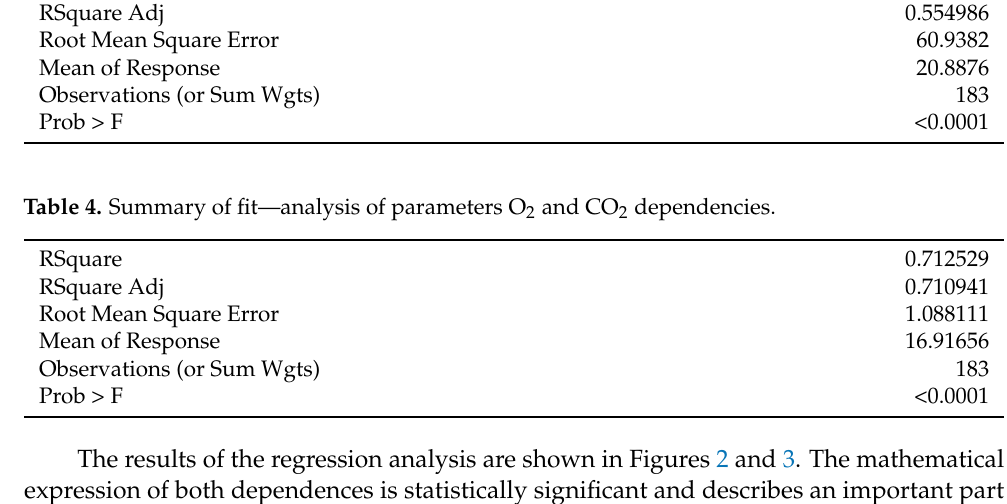
Figure 5. Analysis of variability CO 2 with the influence of the depth. Table 5. Result of Kruskal–Wallis tests—analysis of CO 2 variability with the influence of the date. Level